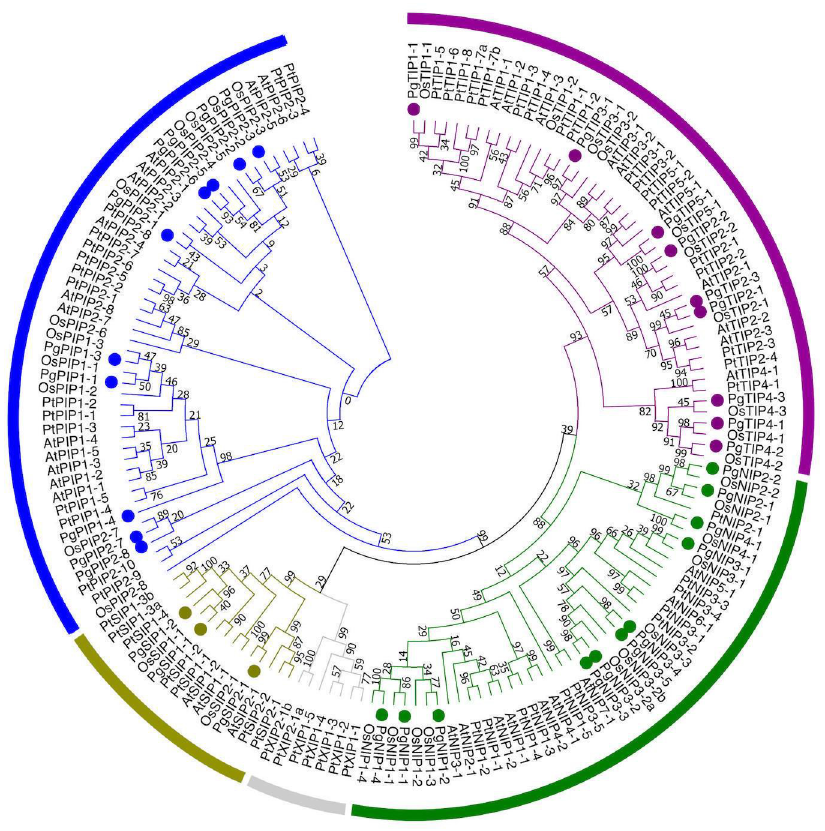
Fig 2. Phylogenetic relationship among aquaporins isoforms from pearl millet, Arabidopsis, rice and poplar. A phylogenetic tree was generated using the Maximum Likelihood method with 1000 reiterations in MEGA7. Bootstrap values above 50% are represented. The PIP, TIP, SIP, NIP and XIP family clades are represented by blue, grey, purple, green and red, respectively. Pearl millet sequences are indicated by colored dots.